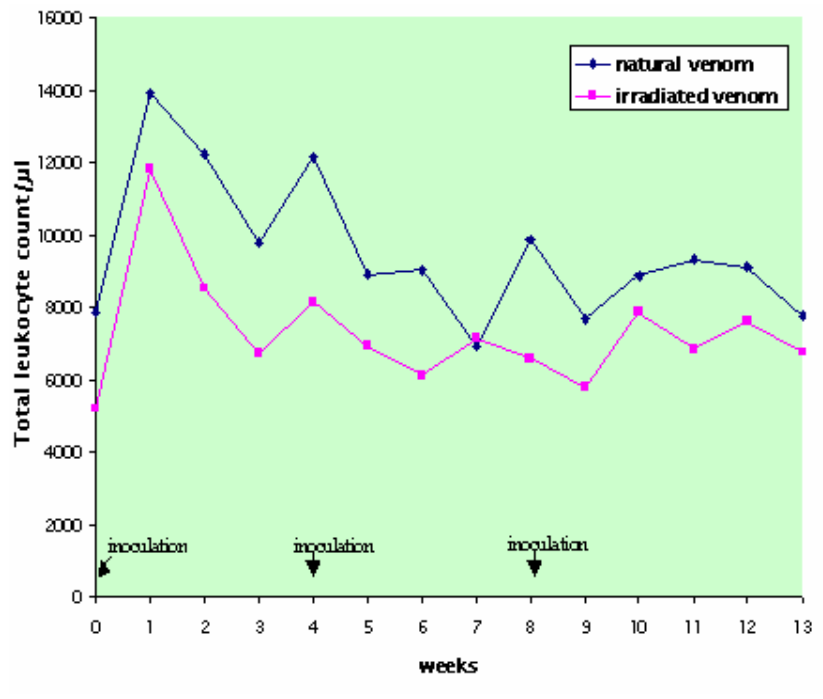
Figure 1. Mean values of total leukocyte count (cells/ µ L) in sheep (n=12) inoculated with -irradiated (IrV) crotalic natural (NV) and Cobalt 60